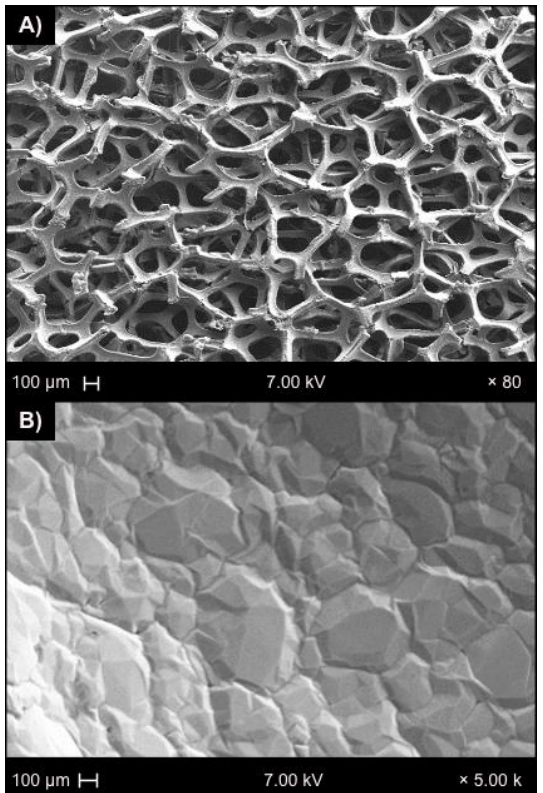
Figure 5. Scanning electron microscopy (SEM) images of ( A ) low (×80) and ( B ) high (×5000) magnification of graphene foam.